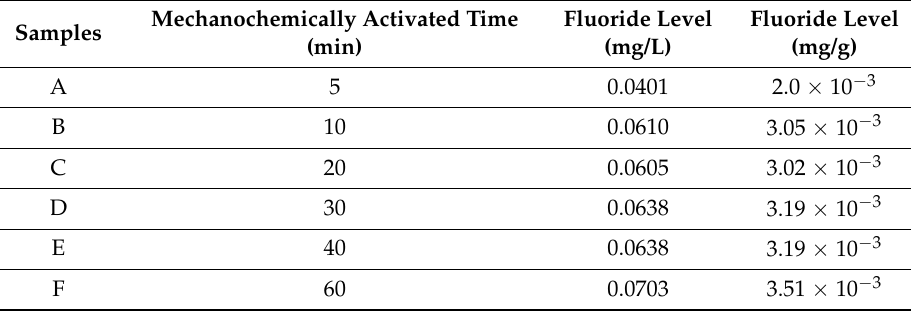
Table 1. Fluoride levels in clay soil samples activated at different contact times.